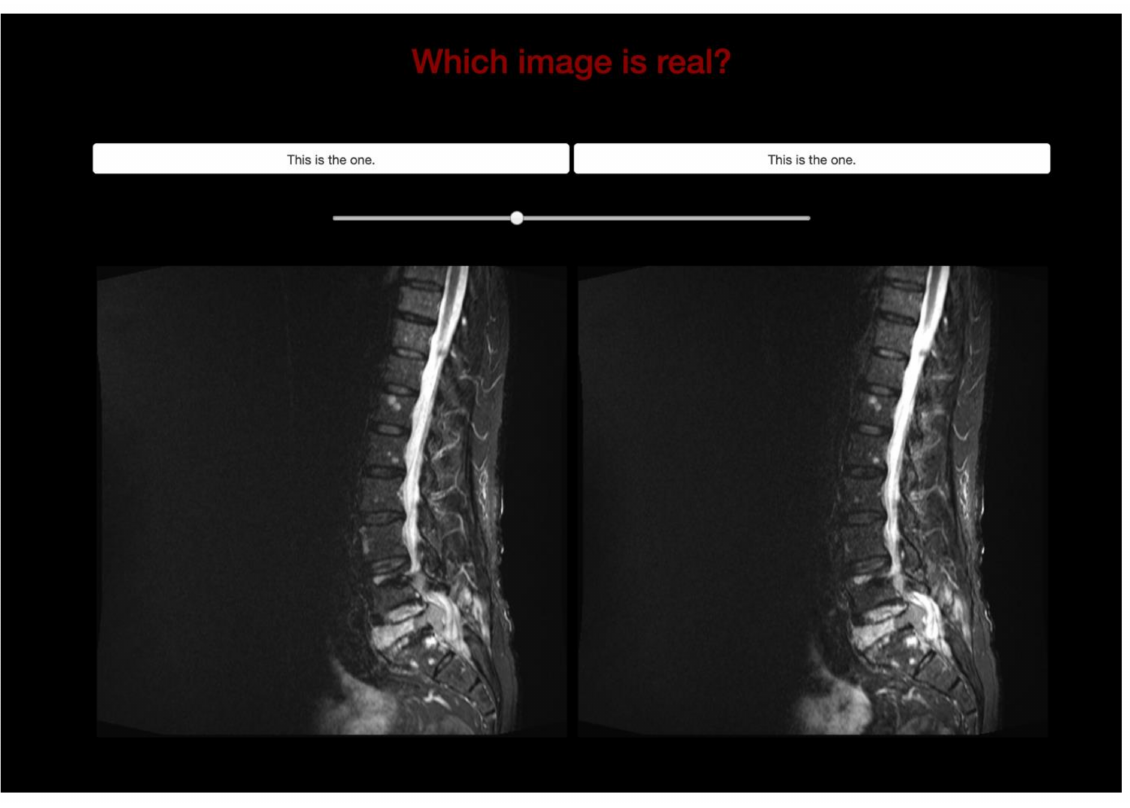
Figure 1. A/B-test to identify the real STIR sequence.